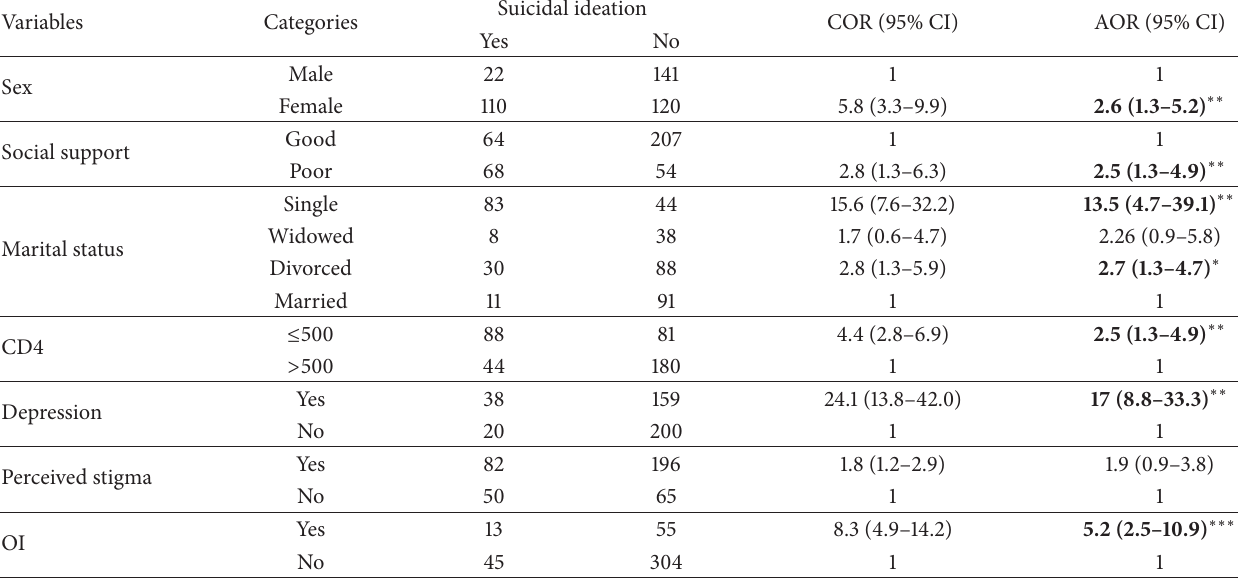
Table 5: Factors associated with suicidal ideation of participants at Debark Hospital Northwest, Ethiopia, 2015.